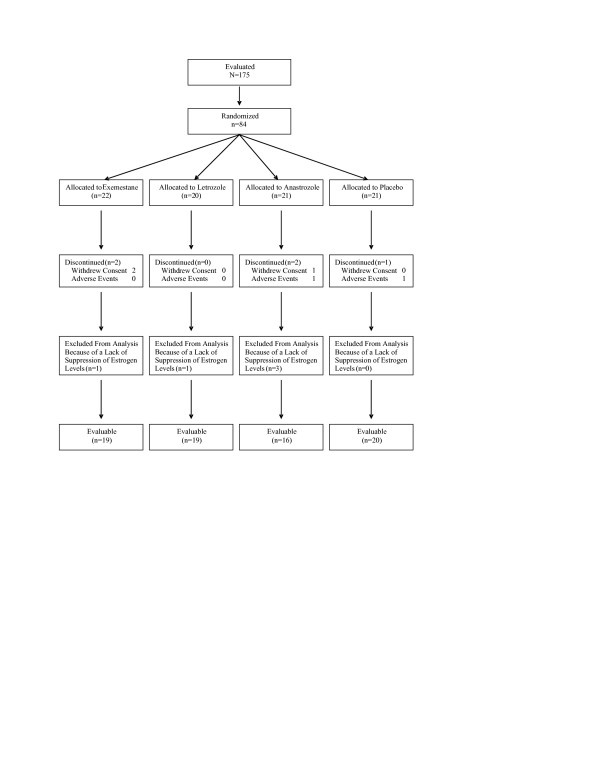
Patient disposition.